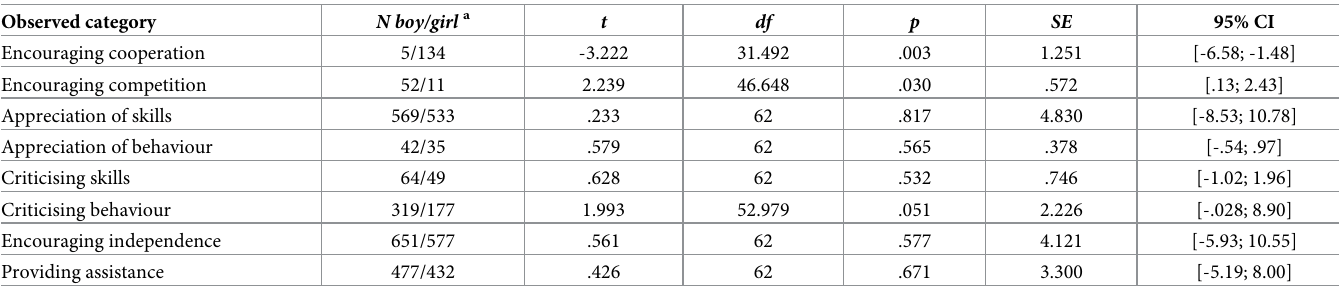
Table 4. T test results and number of behaviours observed in each